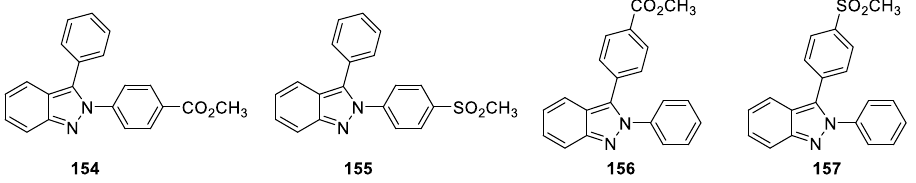
Figure 43. Chemical structures of 2,3-diphenyl-2 H -indazole derivatives 154 – 157.